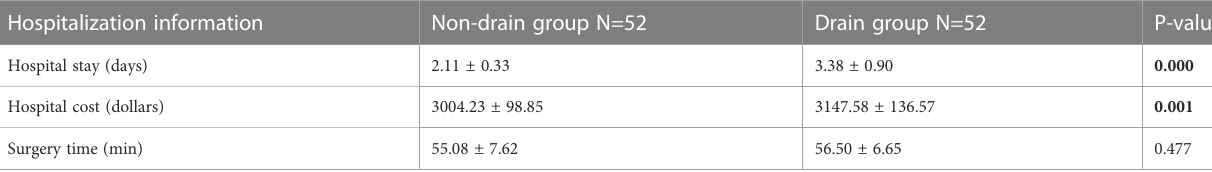
TABLE 3 Comparison of hospitalization information between the non-drainage and drainage